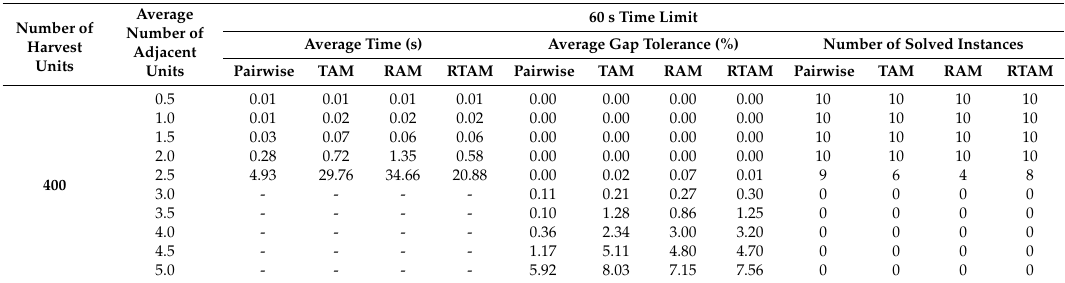
Table 4. Solving time, gap tolerance and number of solved instances for 60 s time limit and 400 harvest units.